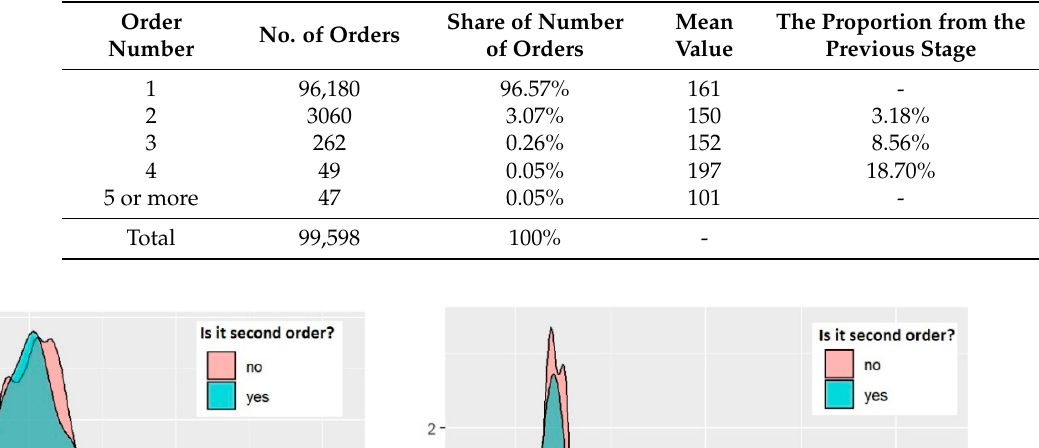
Table 1. Sequential orders analysis.